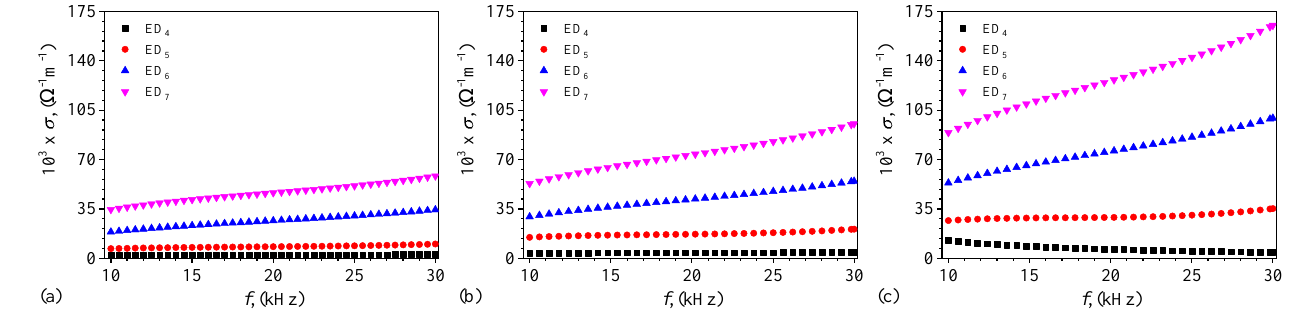
Figure 14. Variations in electrical conductivity σ with the frequency f of a sinusoidal electric field at discrete values of the magnetic flux density B . ( a ) B = 0 mT. ( b ) B = 200 mT. ( c ) B = 400